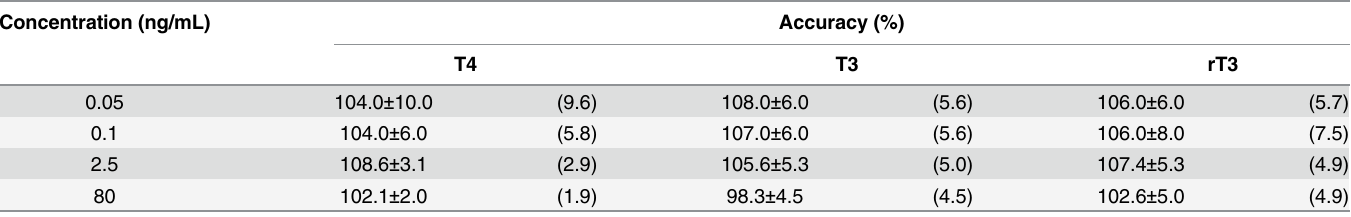
Table 3. Precision and Accuracy of inter-day assay. Concentration